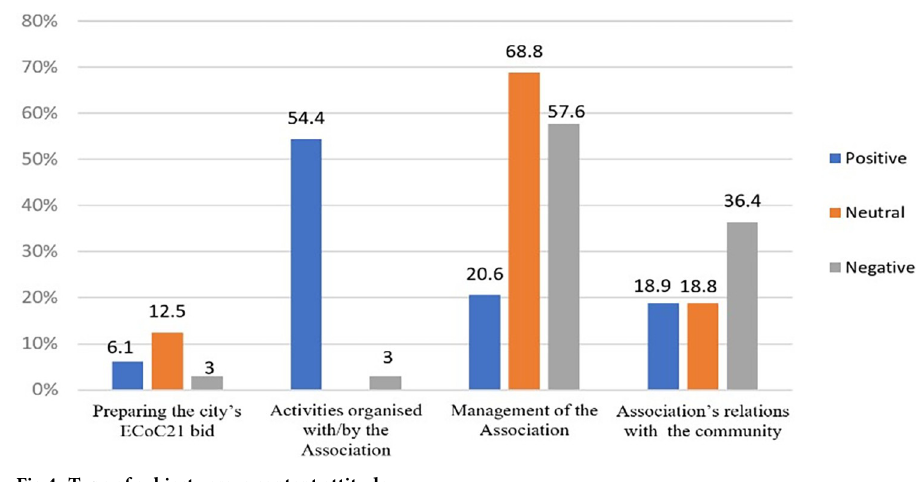
Fig 4. Type of subject versus content attitude.